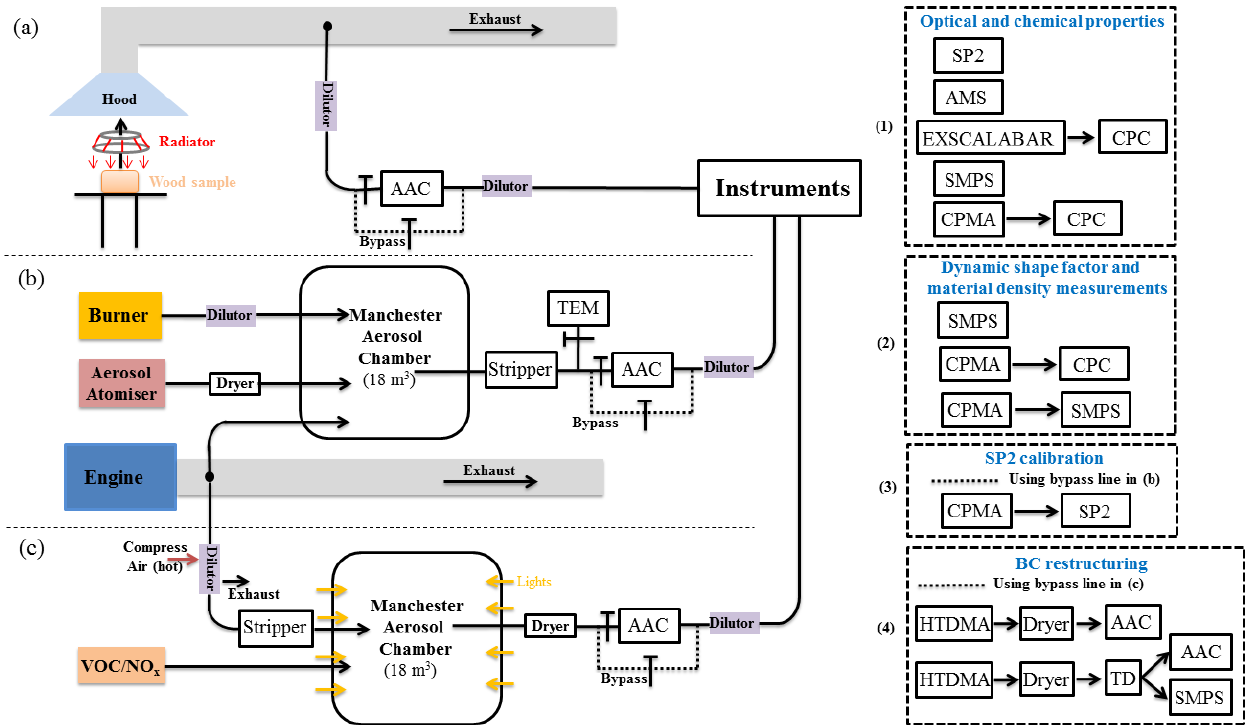
Figure 1. Schematic diagram of the experimental configuration for (a) wood combustion; (b) SP2 incandescence signal calibration and BC morphology investigation; (c) brown carbon formation and restructuring of BC. The combinations of instruments described in (1), (2), (3) and (4) represent different measurement configurations used to enable characterisation of specific aerosol physiochemical parameters, as described in the main text. The instrument set (1) was used for measurements of aerosol optical properties (and thereby to enable the retrieval of refractive index for BC/BrC aerosols, subject of a future publication) and organic chemical measurement for wood combustion (setup a) and chamber (setup c) experiments; instrument set (2) was used for dynamic shape factor measurements for BC and material density measurement for organic aerosols (setup a and b); instrument set (3) was used for SP2 incandescence signal calibration (setup b); instrument set (4) was used for BC restructuring experiments (setup